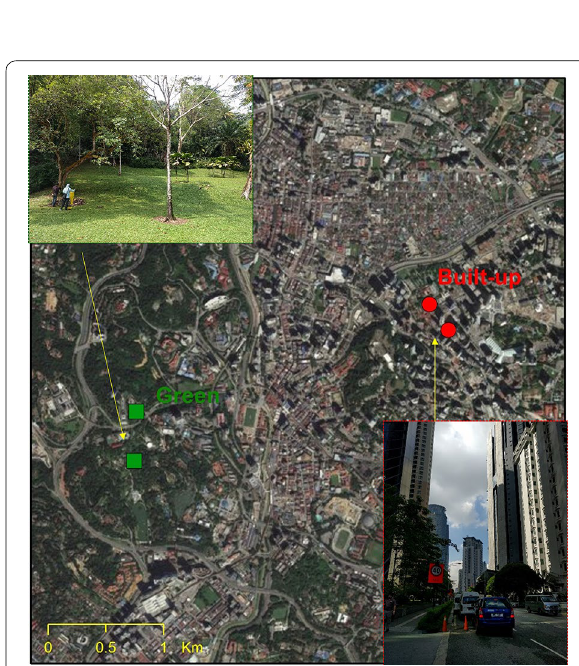
Fig. 7 Locations and images of the selected built‑up area locations in City Centre (red dots) and green area in Tasik Perdana (green dots) (ArcMap 10.5 Base